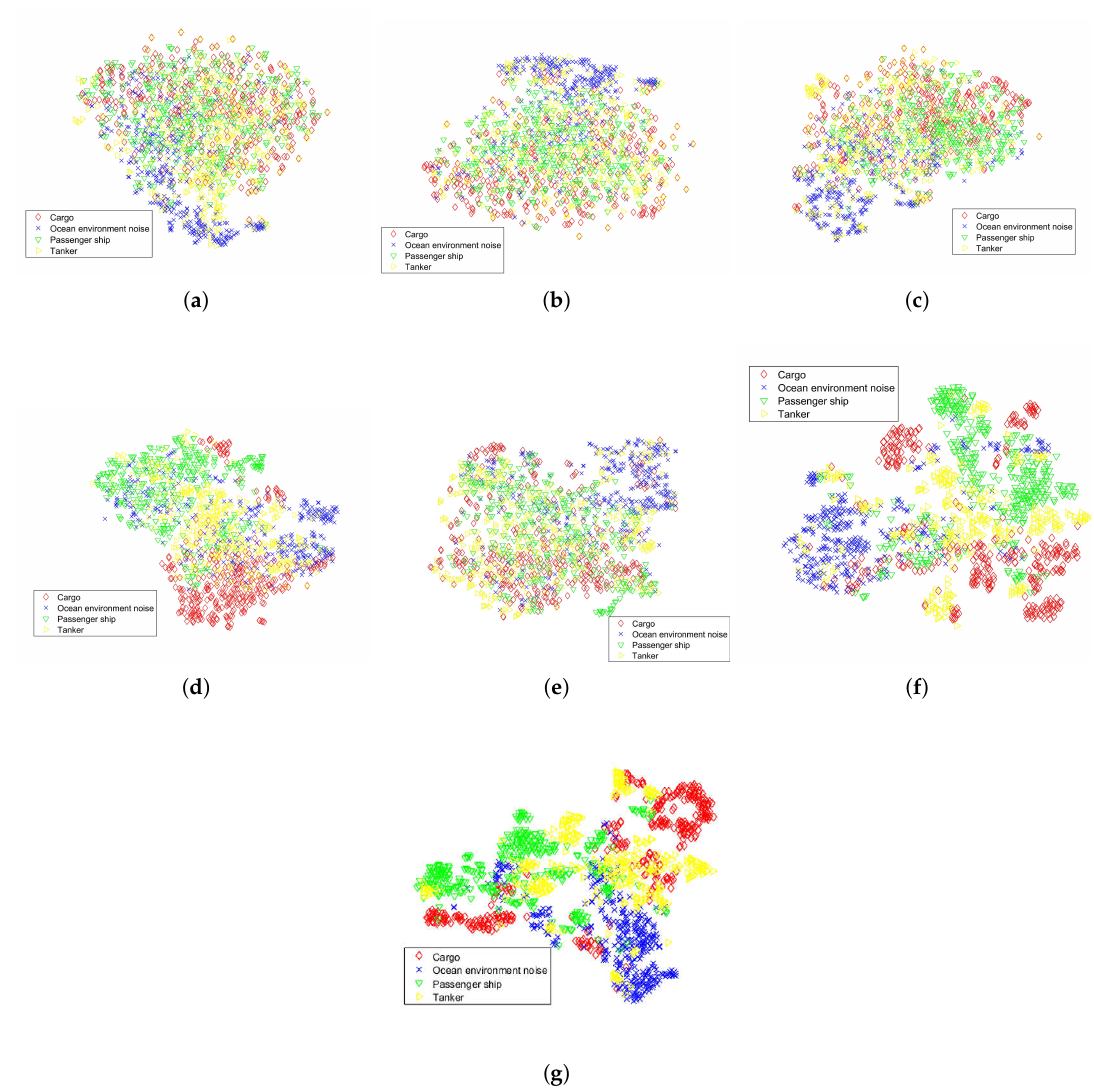
Figure 4. Result of t-SNE feature visualization. ( a – e ) Feature groups of deep filter sub-networks; ( f ) Features of layer-1; ( g ) Features of